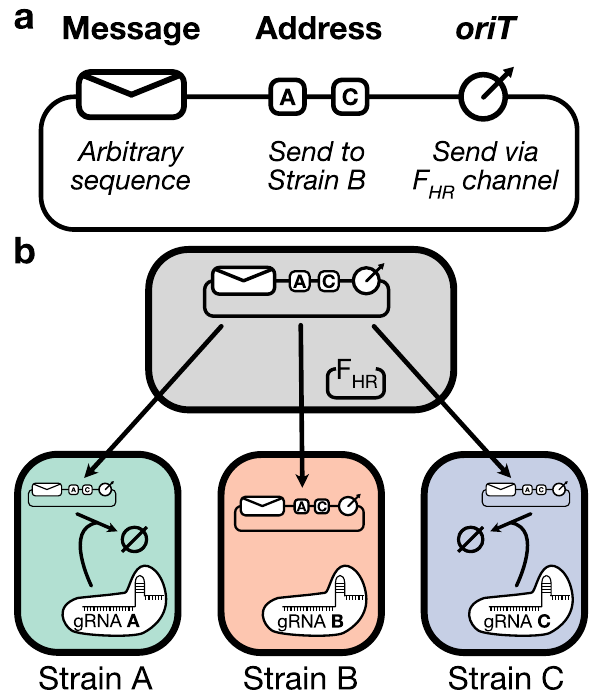
Fig.2|AddressableDNAmessaging.a SchematicofanaddressableDNAmessage. The content of the message is an arbitrary genetic sequence, and the address region uses gRNA binding sites to act as a blocklist that determines the message ’ s recipient list by excluding transfer to all encoded strains. The origin of transfer ( oriT ) allows the message to interact with the cognate horizontal gene transfer machineryinthesendercell. b Schematicoftransferblocking.TheDNAmessageis initially transferred promiscuously to all receiver strains in the population. As the message enters a receiver cell, the binding sites on the address region become exposed to cleavage by the Cas9 – gRNA complex expressed within the cell. This cleavageonlyoccursifabindingsiteontheaddressmatchesthegRNAexpressedin thereceivercell,thusensuringthatthemessageonlypersistswithinitsappropriate recipients by eliminating the messages sent to invalid